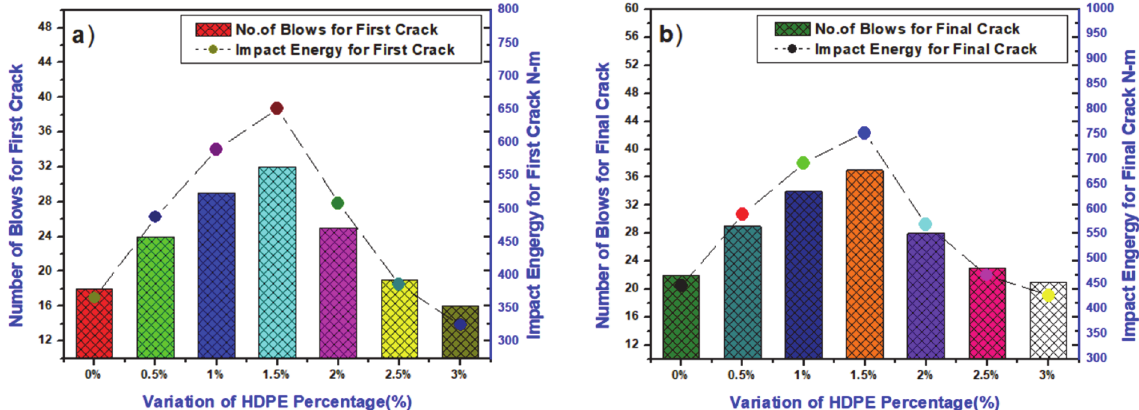
Figure 9. Variation of impact energy and number of blows (a) first crack (b) final failure.